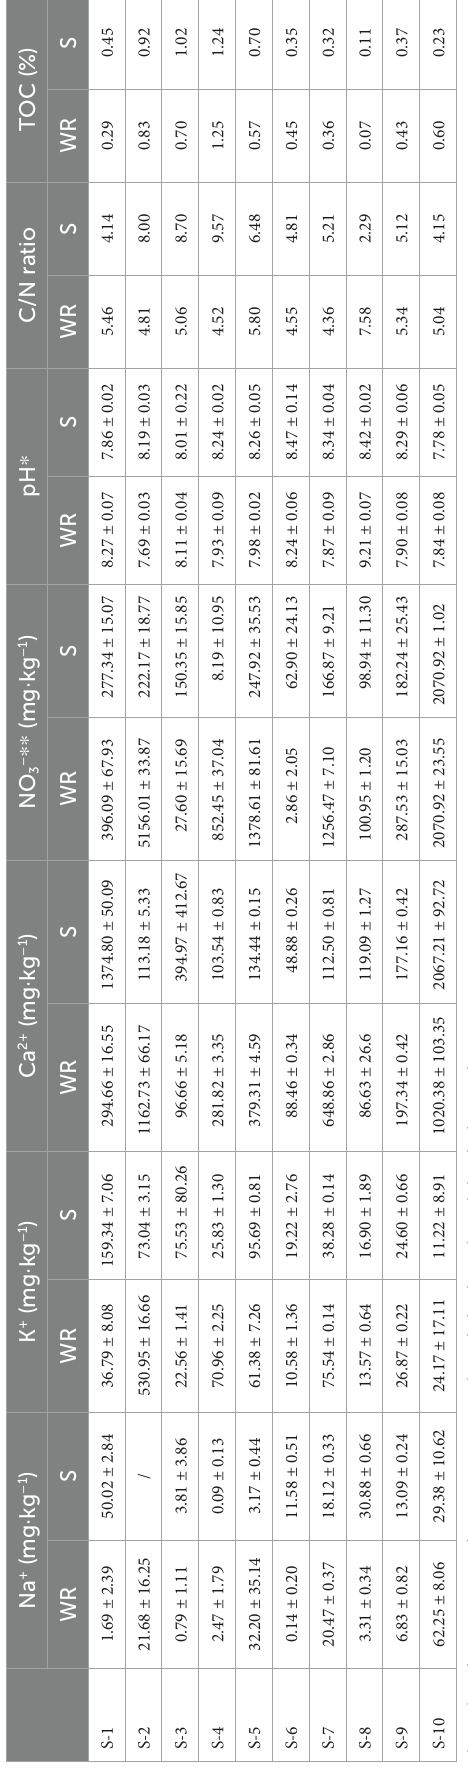
indexes of weathered rocks were significantly negatively correlated with pH (Figure 2A), and those in sediments positively correlated with nitrate (Figure 2B). Bacterial communities in weathered rocks and sediments were clearly separated by the NMDS ordination plot (Figure